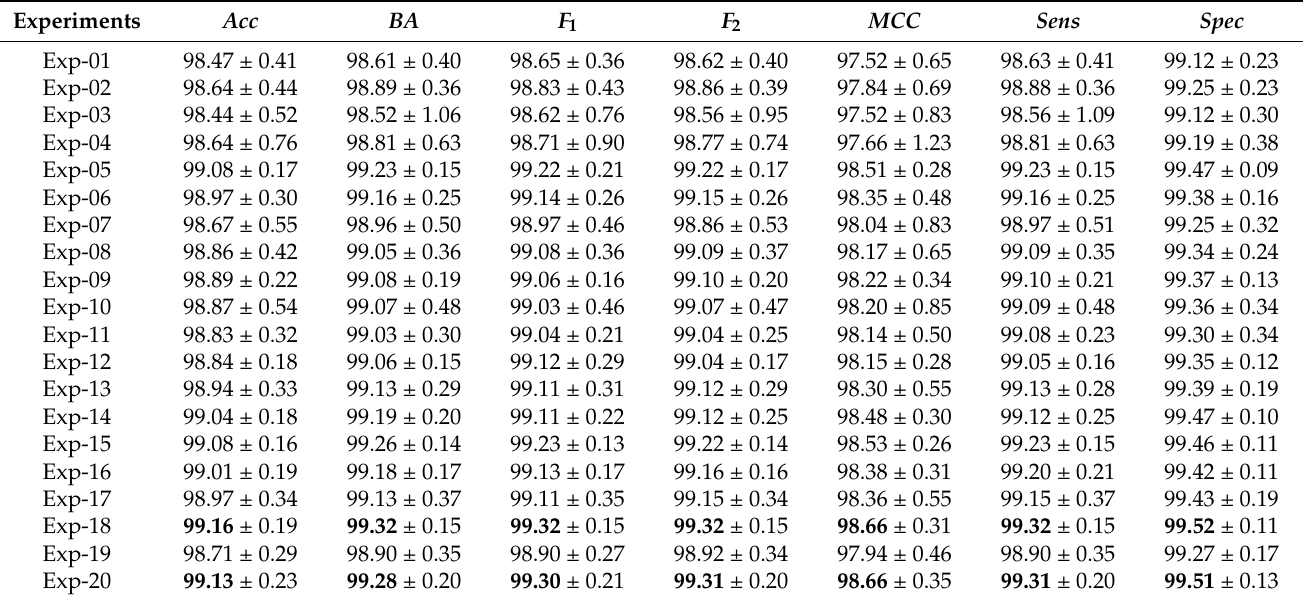
Table 7. Evaluation metrics by experiment before bootstrapping. Average and standard deviation per each metric are given in percentage. The best top three values per metric are highlighted in